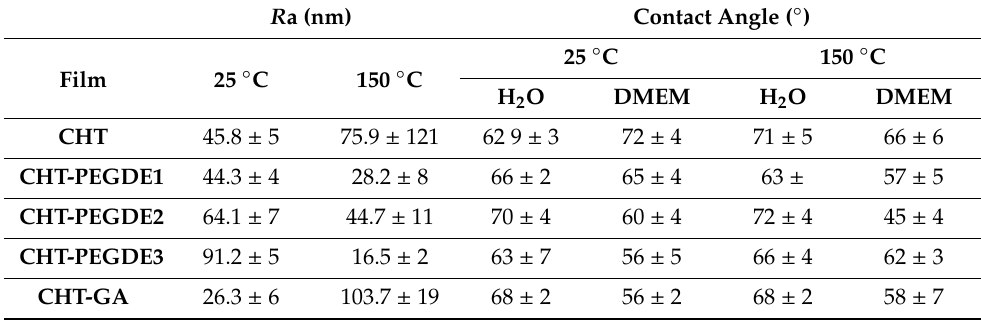
Table 5. Roughness and contact angle of the films dried at 25 ◦ C and additionally dried at 150 ◦ C. R a